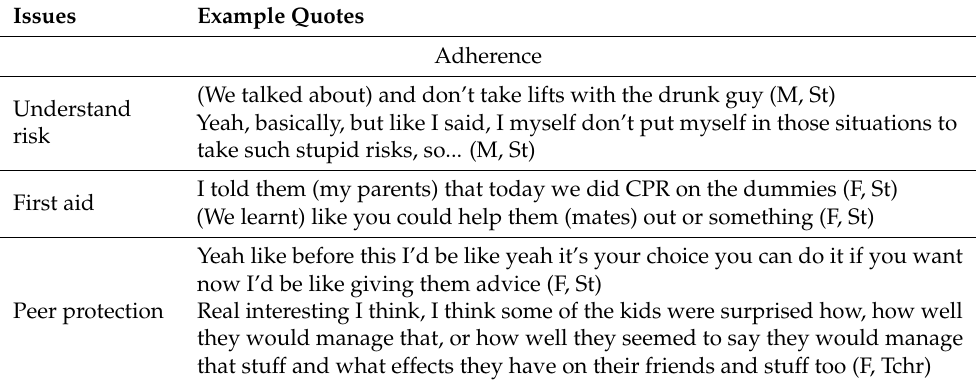
Table 2. Summary of implementation